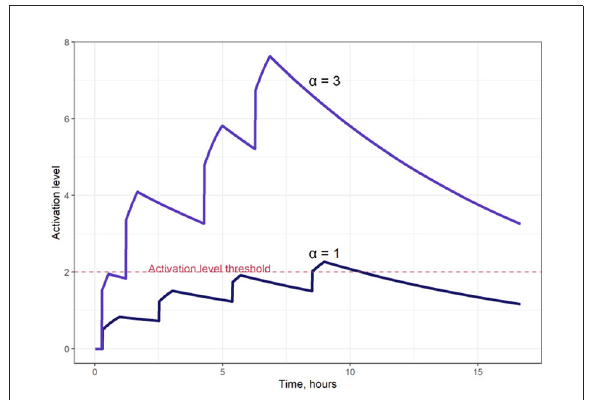
FIGURE2 Examples of T cell activation dynamics, for two different saturation levels of the activation signal (parameter α in Equation 4); α = 1 (lower curve); α = 3 (upper